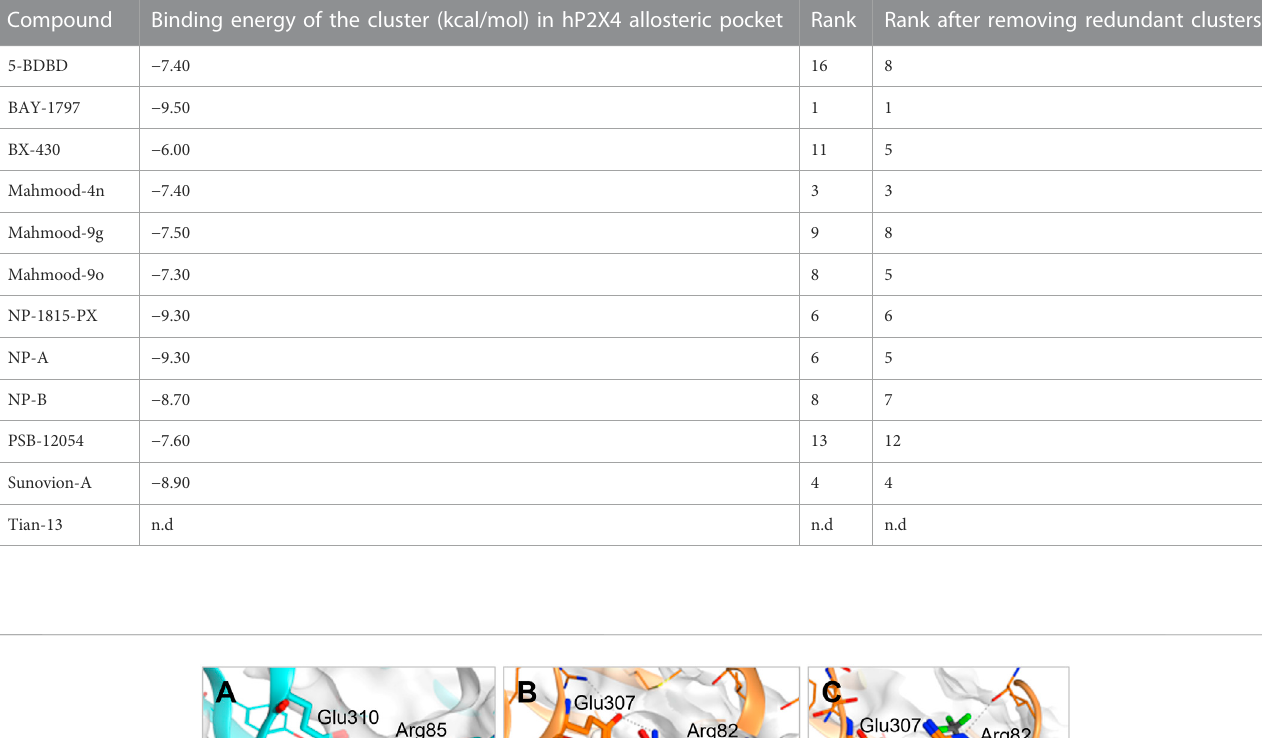
TABLE 4 Computed binding energies of P2X4 antagonists docked into the human P2X4 allosteric pocket in a blind docking simulation run using the AchillesDock Server. Ranking of the cluster of poses docked in the allosteric pocket (pocket where Ile-312 lies, investigated in this work). Compound Binding energy of the cluster (kcal/mol) in hP2X4 allosteric pocket